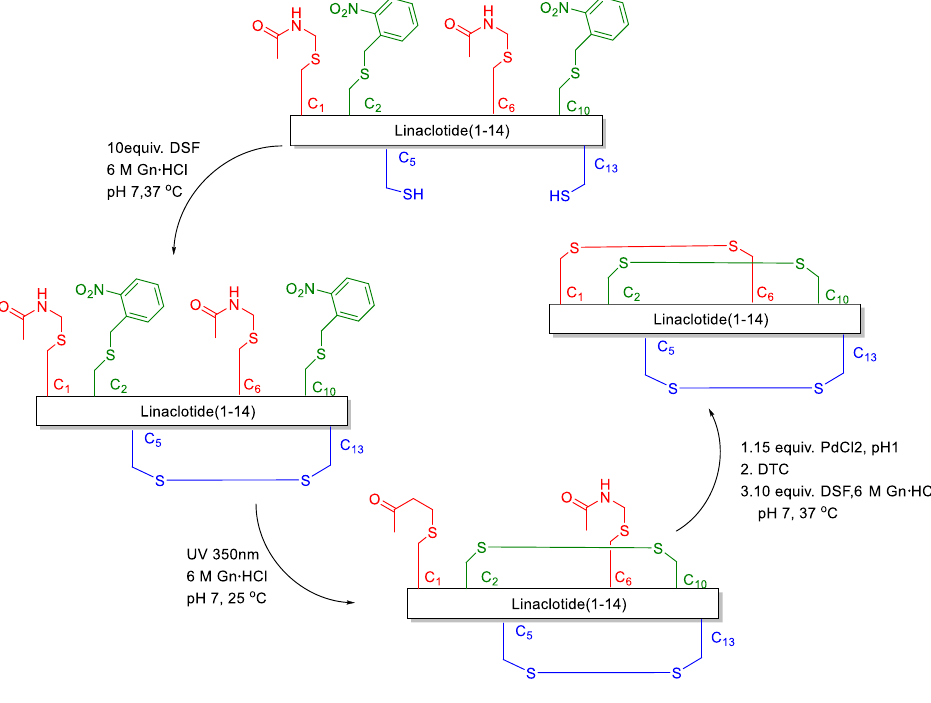
Figure 2. Linaclotide synthesis of Brik’s group .